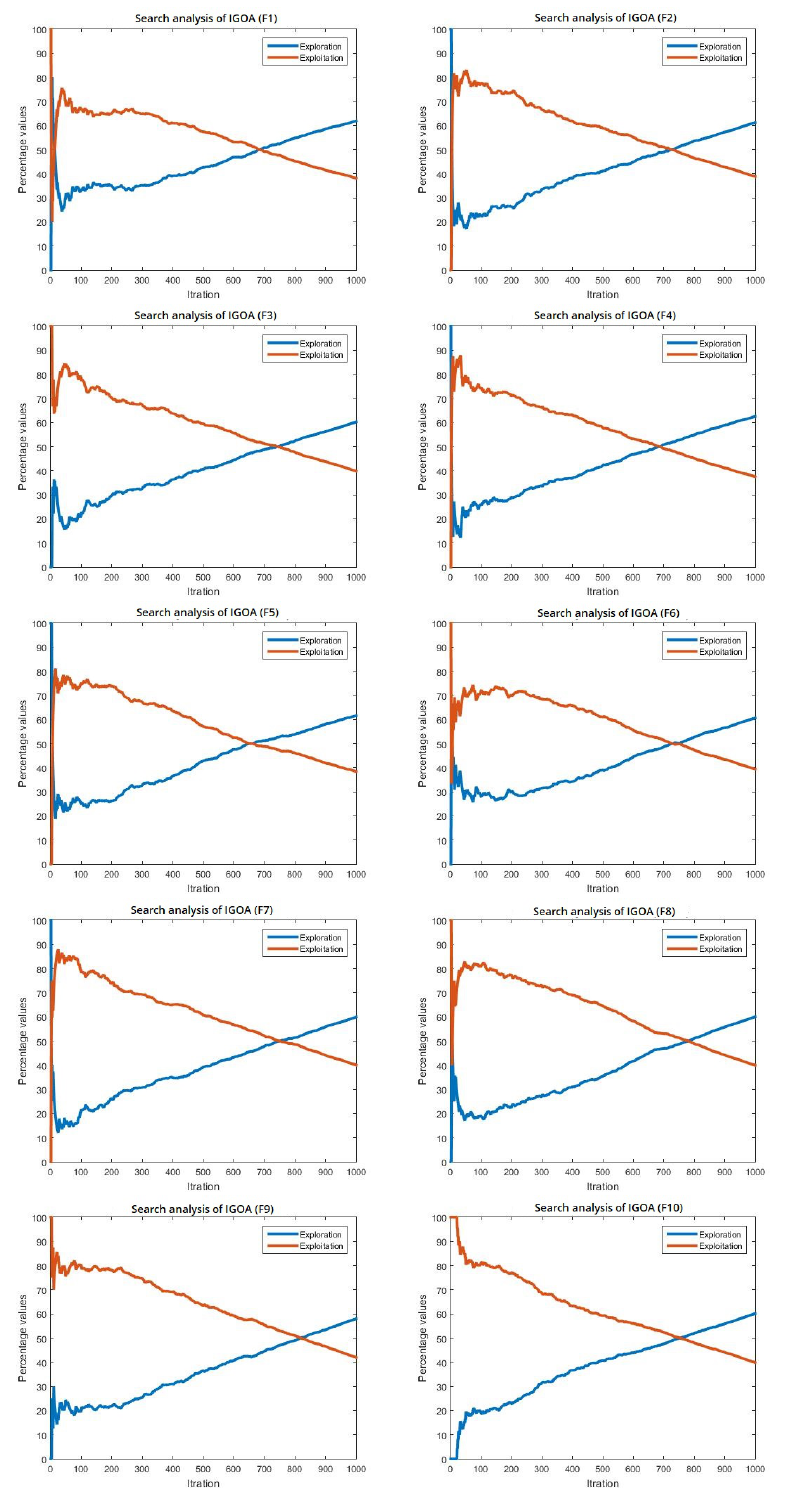
Figure 9. The exploration and exploitation of the optimization